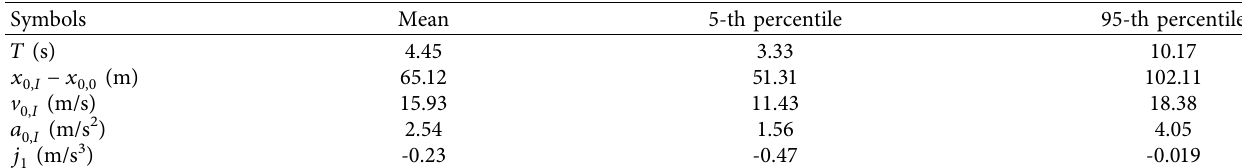
Table 3: Statistics of trajectory planning results.